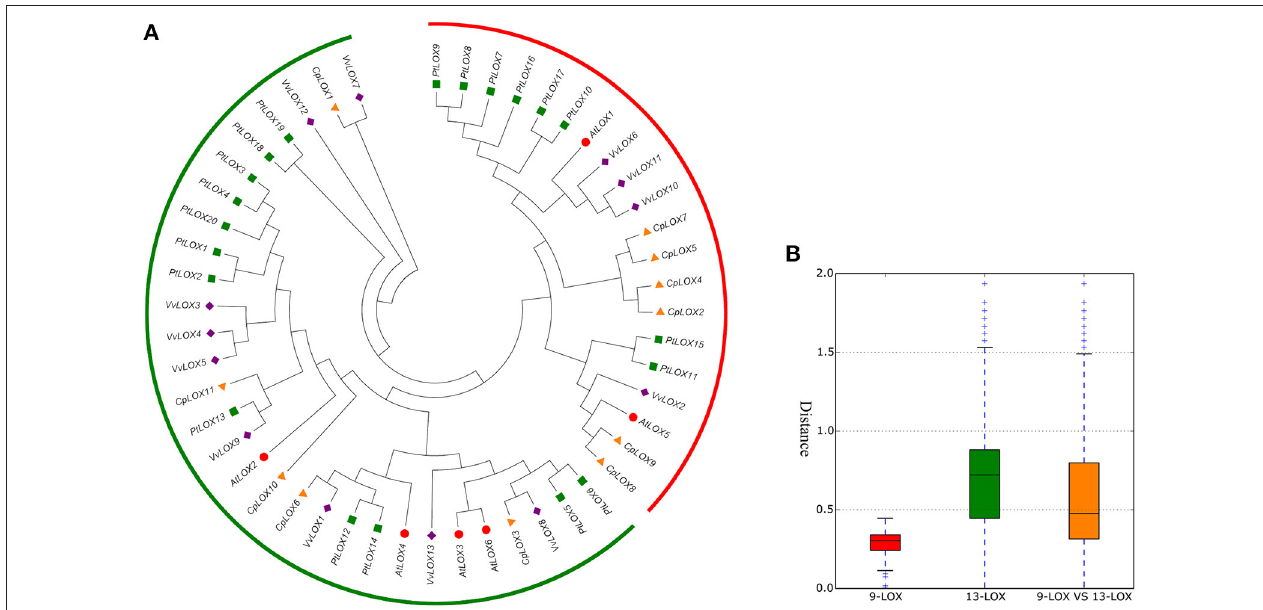
FIGURE 1 | Phylogenetic relationships among LOX genes in four rosid plants (A) and the genetic distance among different sub-families of LOX genes (B). Gene sub-families are indicated with different colors. Taxon labels are depicted in red for the 9-LOX clade and in green for 13-LOX clade. In (A) , the phylogenetic tree was constructed using Minimum-evolution (ME) using MEGA6. The LOXs of Arabidopsis are indicated by red circles, Carica are indicated by orange triangles, Populus are indicated by green squares and Vitis are indicated by purple rhombus